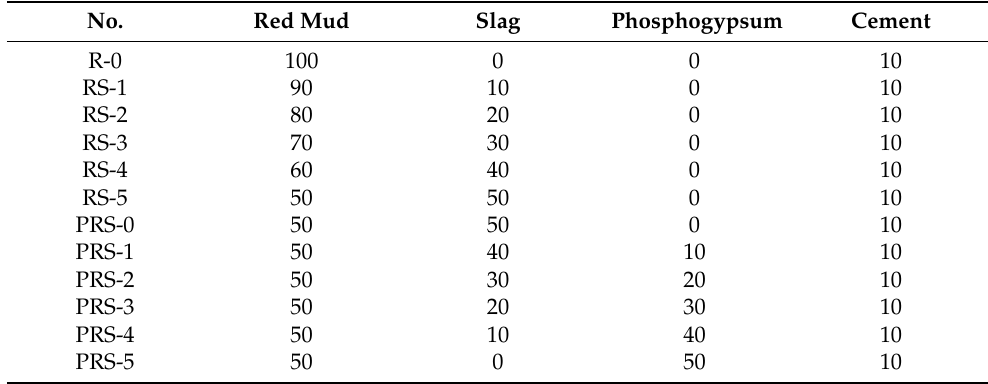
Table 2. Mixture proportion (wt.